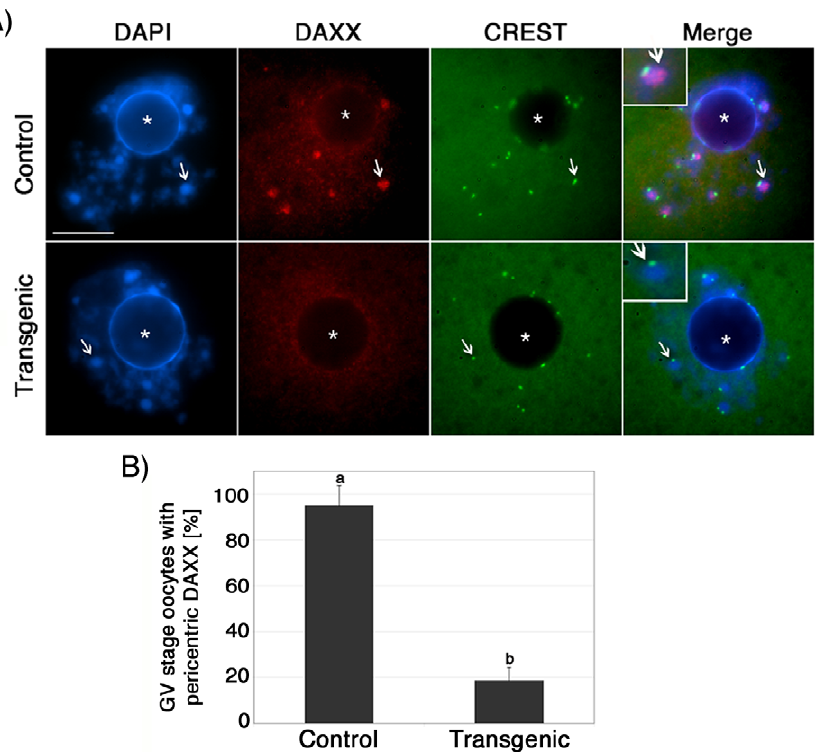
Figure 4. ATRX is required to recruit the transcriptional regulator (DAXX) to pericentric heterochromatin in mammalian oocytes. ( A ) Top Panel : Nucleus of a control oocyte showing a precise co-localization of DAXX (red) with bright, DAPI-stained pericentric heterochromatin domains (arrows). The position of the centromere is indicated by CREST (green). Lower Panel : Analysis of transgenic oocytes demonstrated that in the absence of ATRX, the transcriptional regulator DAXX fails to associate with pericentric heterochromatin domains while nucleoplasmic expression of DAXX persists. The position of the nucleolus is indicated by (*). ( B ) Proportion of germinal vesicle (GV) stage oocytes showing pericentric DAXX localization. More than 80% of transgenic oocytes fail to recruit DAXX to pericentric heterochromatin. Data are presented as the mean 6 s.d. of three independent experiments. CREST immunolocalization (green) was conducted as an experimental control for centromeric-kinetochore integrity. Scale bars =10 m m.